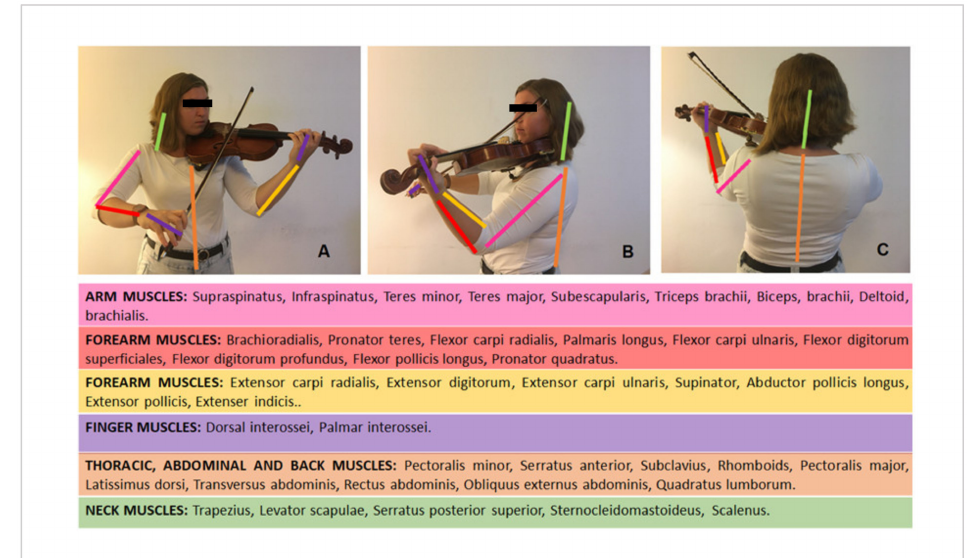
Figure 1. Representation of di ff erent muscles involved when the violin is played. Picture ( A ) shows an anterior view of the position when the violin is played and the involved muscles, picture ( B ) represents a lateral view, and picture ( C ) shows a posterior view of the same